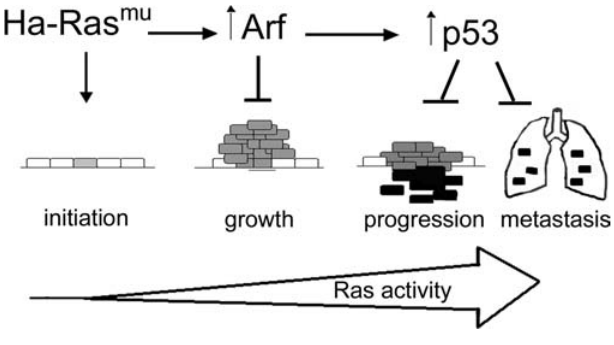
Figure 7. An Integrated Model of SCC Progression At the genetic level, treatment of mouse skin with DMBA induces mutations in Hras resulting in initiated cells that express constitu- tively active Ras protein (grey rectangles). TPA treatment is required for clonal expansion of these Hras mutant cells to form papillomas. Frequent duplication of the mutant Ras allele in papillomas indicates increased Ras signaling is favored. Mutation of p53, as well as additional Ras gene amplification, is seen in carcinomas, particularly in the most aggressive tumors (black rectangles). At the signaling level, mutant Ras upregulates p19 Arf (Arf), which in turn activates p53. p19 Arf , in turn, inhibits growth of Hras-driven tumors in a p53- independent manner. p19 Arf , acting through p53, also inhibits malignant progression and metastasis. As Ras signals through p19 Arf and p53, selection for subsequent mutations in p19 Arf or p53 is a direct consequence of the initial Ras mutation. In this model, Ras drives tumor progression through direct signaling effects and by dictating the evolution pathway of the tumor. DOI: